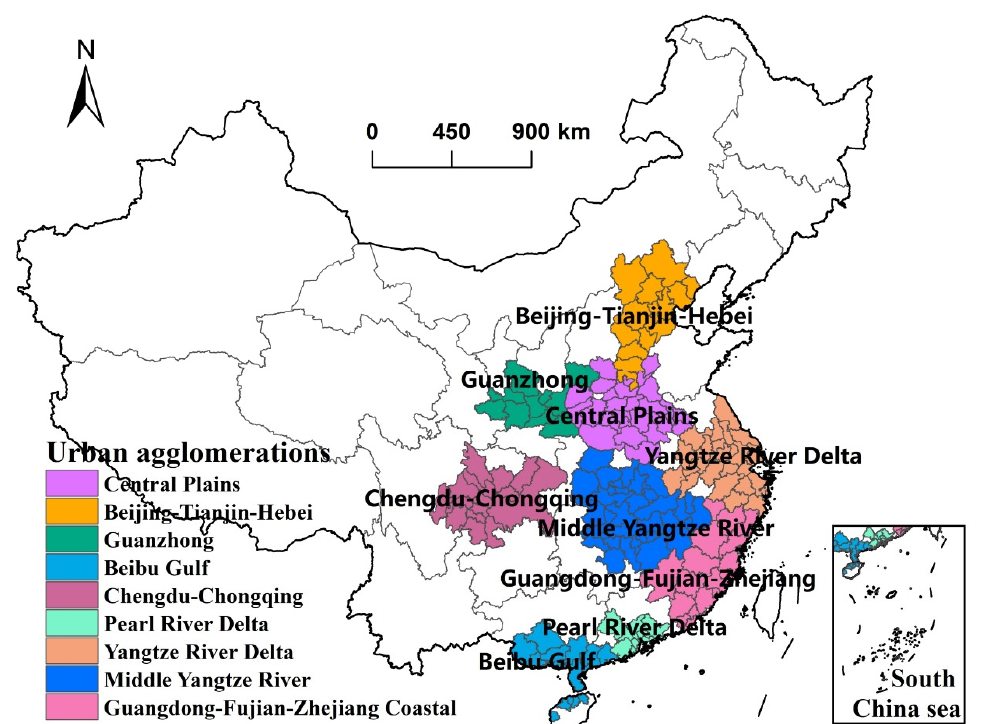
Figure 3. Nine national urban agglomerations in China. Table 2. Scaling exponents of industrial land of night t urban agglomerations in China,